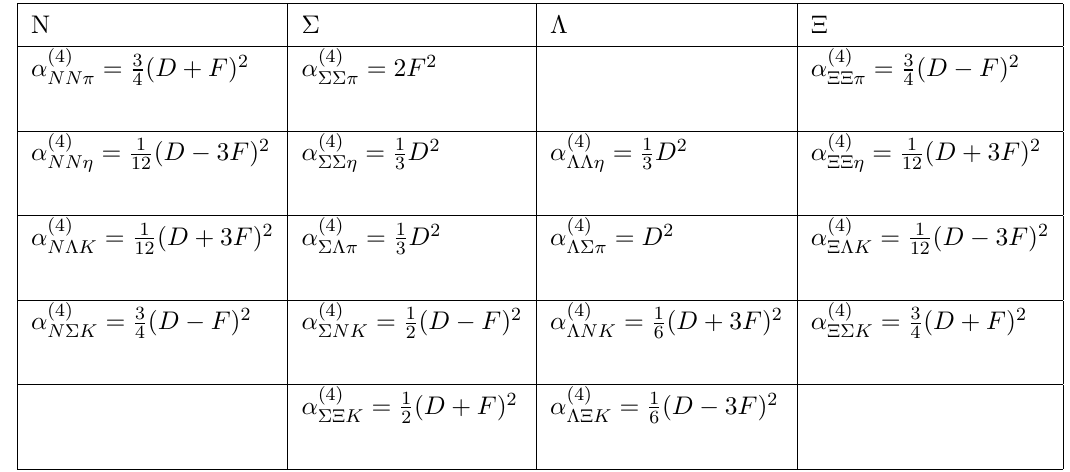
Table 5 . Combined coe(cid:14)cients of the O ( p 4 ) self-energy